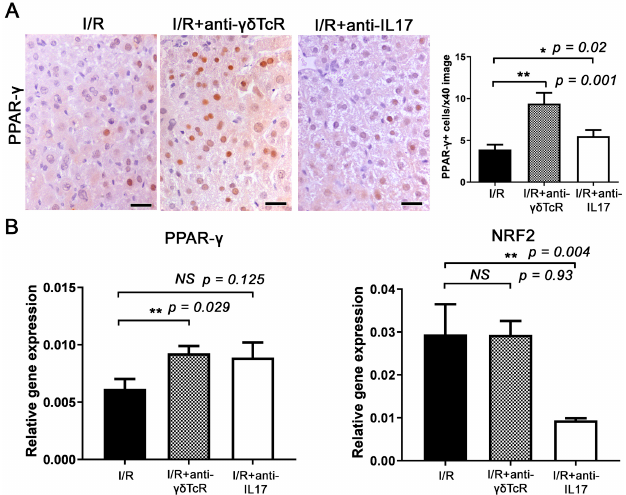
Figure 5. Anti- γδ TcR and anti-IL17a increase PPAR- γ and reduce NRF-2 in the livers of mice with I/R-injury. ( A ) Hepatocytes with a nuclear PPAR- γ -positive immunohistochemical signal are more significantly present in the livers of pretreated mice in comparison with the controls. ( B ) Quantita- tive PPAR- γ gene expression analysis in mouse livers parallels the result of immunohistochemistry. The same analysis shows that the anti-IL17a but not the anti- γδ TcR pretreatment correlates signifi- cantly with NRF-2 reduction in mouse livers after I/R injury. ( A ) Diaminobenzidine chromogen, haematoxylin counterstain. Scale bars: 25 μ m ( A ) and ( B ) Neutralization of either γδ TcR cells or IL17a. * p < 0.05, ** p < 0.01. NS, Nonsignificant.